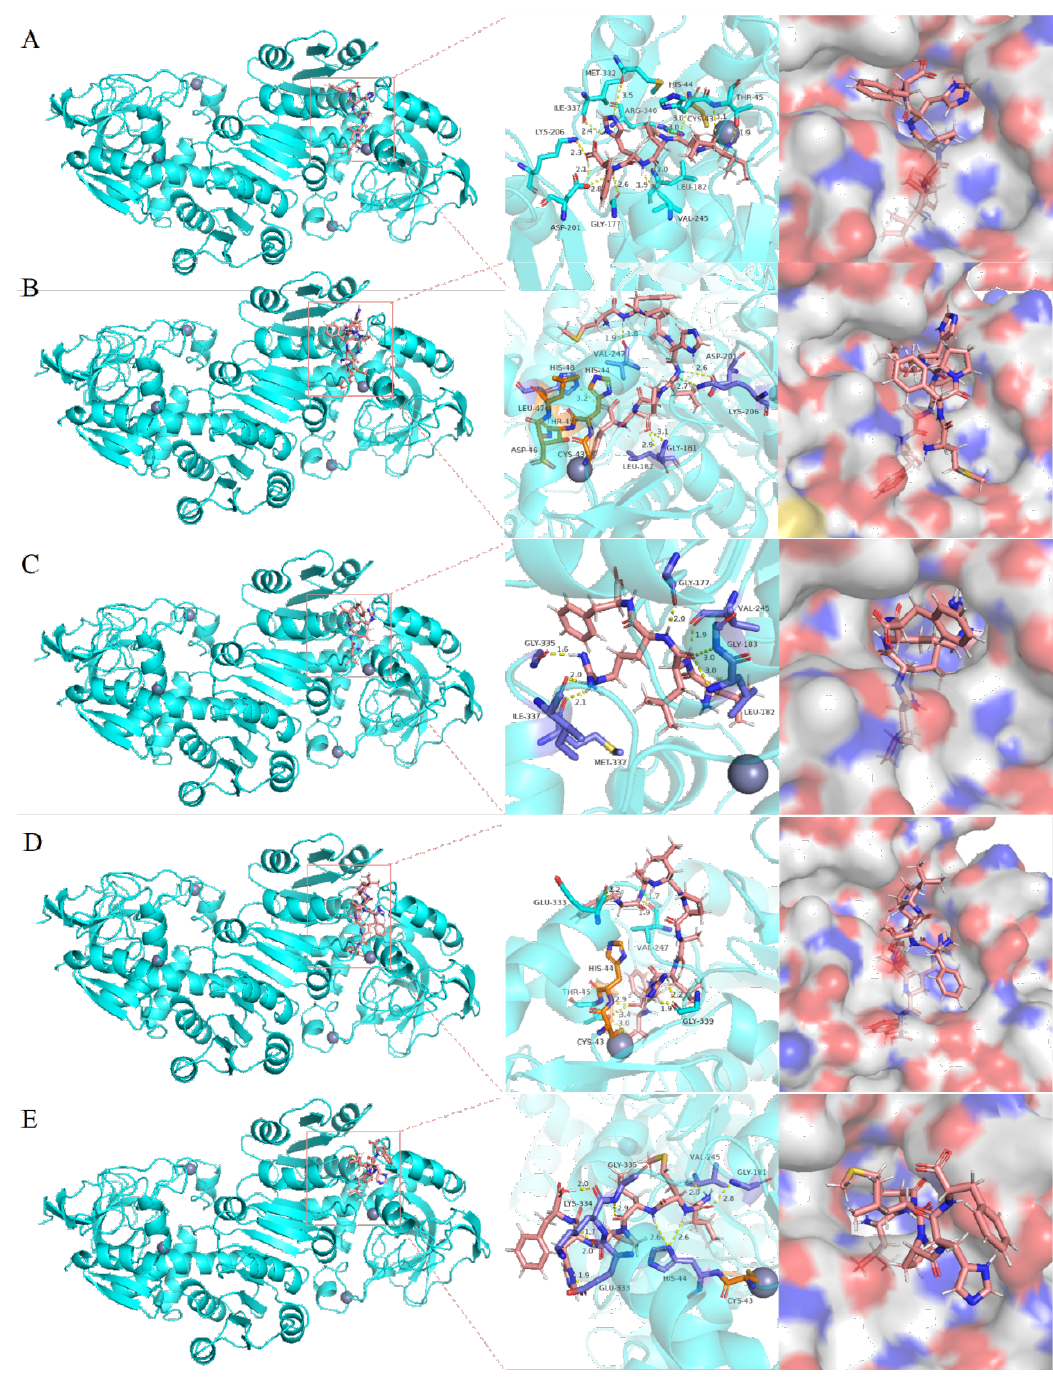
Figure 4. Molecular docking diagram of synthetic peptides ( A ) ILPHF, ( B ) MFPHLPSF, ( C ) LLRF, ( D ) FDLPALRF and ( E ) LMLPHF with ADH. (The 3D pink stick models are peptides, the purple stick models are ADH residues, the orange stick models are ADH residues directly linked to the Zn atom and the gray spherical model is Zn atoms. Hydrogen bonds are shown with yellow dotted lines.)